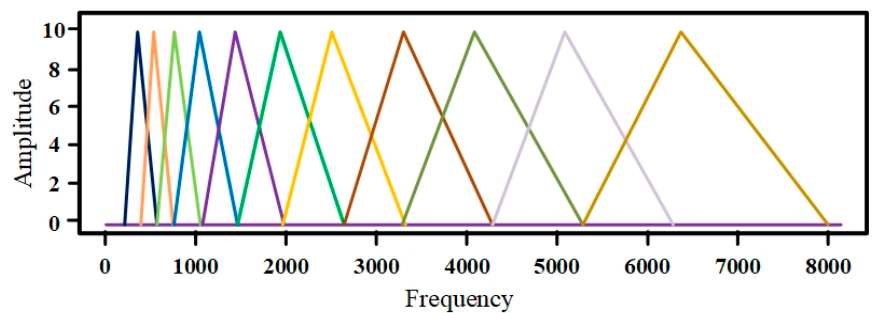
Figure 4. Mel-bank filter with n = 10.